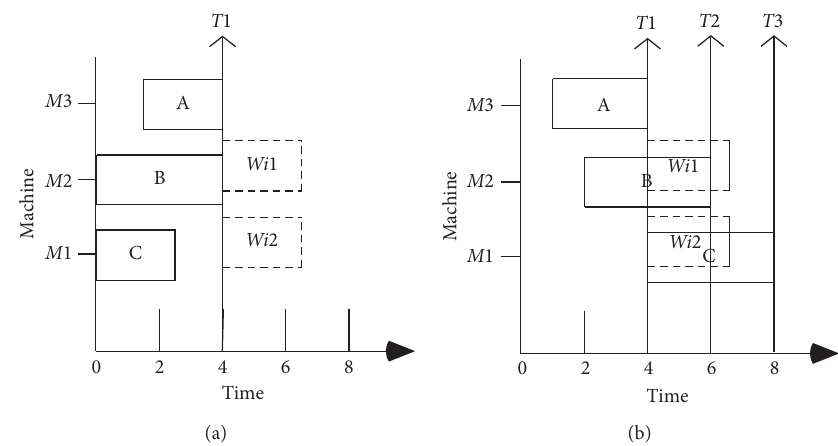
Figure 2: Scheduling analysis at the first quasischeduling time